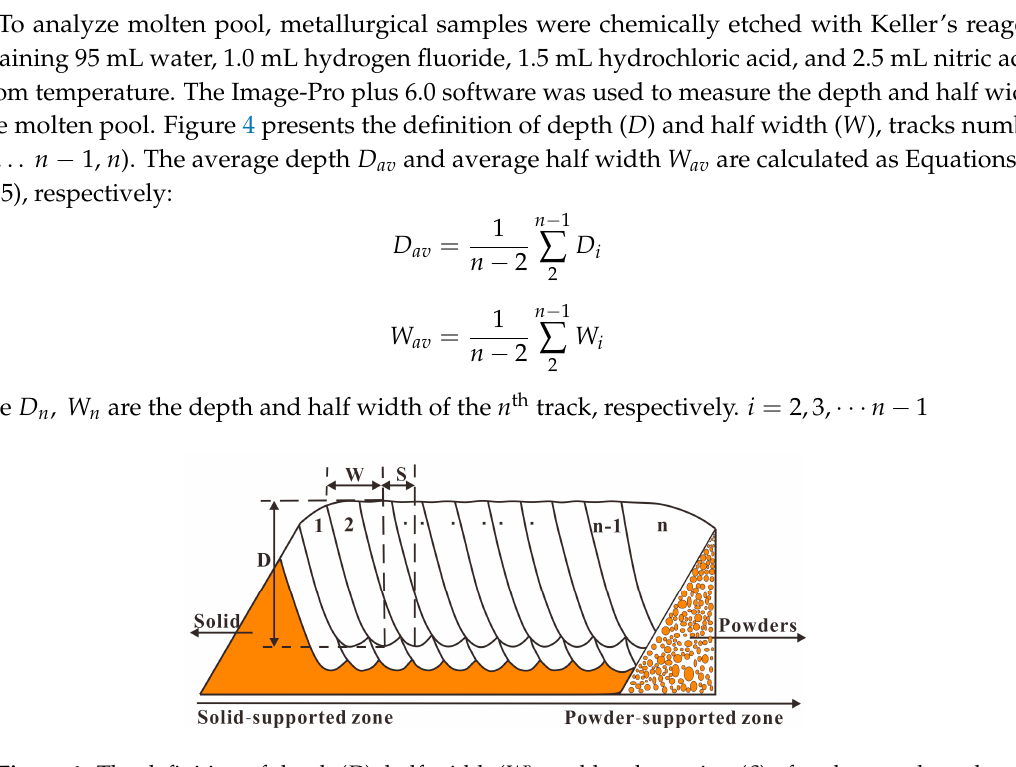
Table 3. Pixel size under specific magnification.